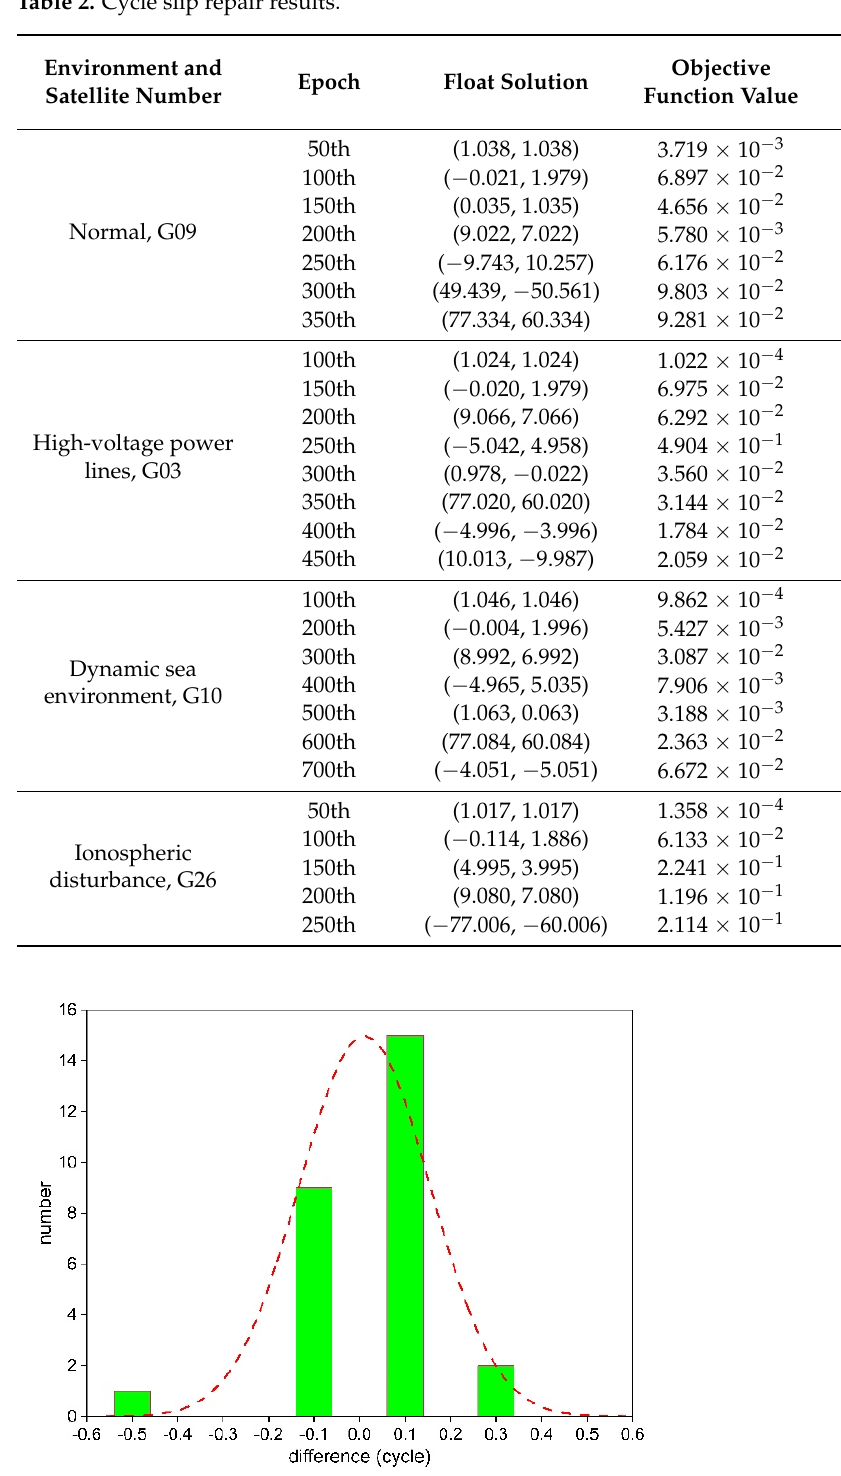
Table 2. Cycle slip repair results.